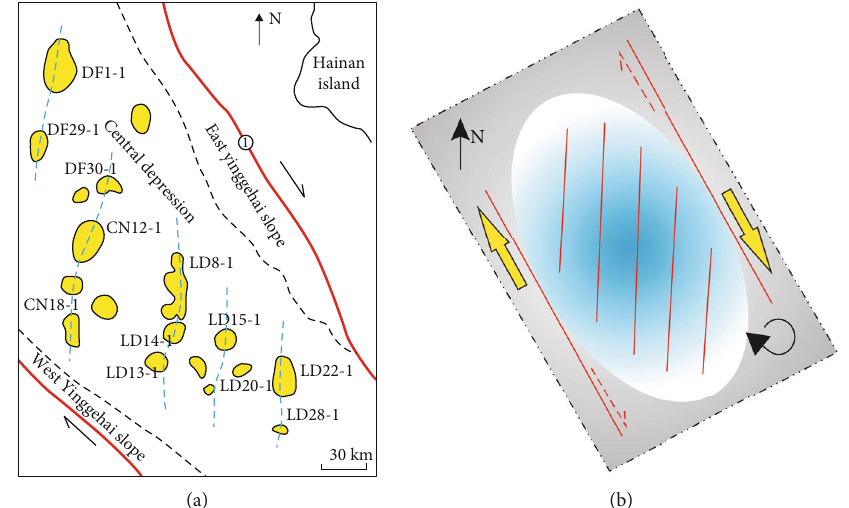
Figure 10: (a) Distribution map of mud diapirs in the Yinggehai Basin; (b) a model of strike-slip environment in Yinggehai Basin.